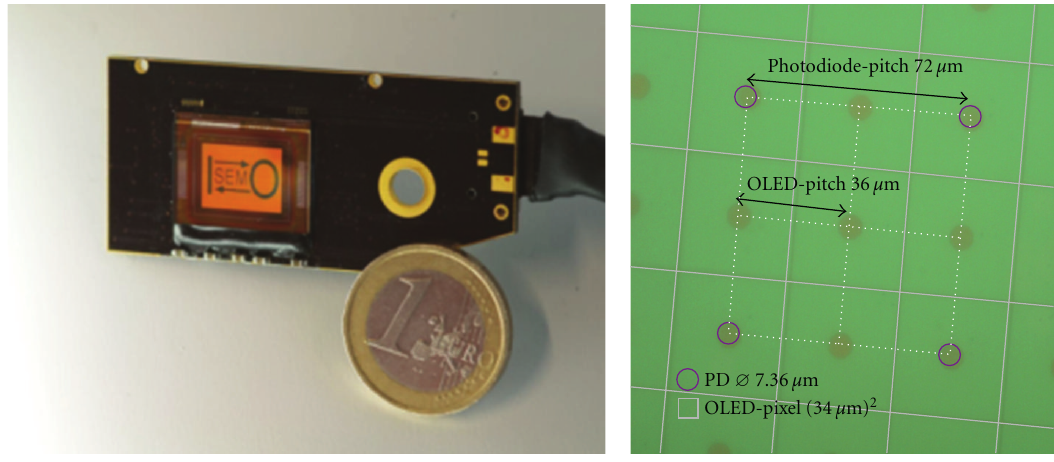
Figure 3: Bidirectional OLED-on-CMOS-microdisplay (at Fraunhofer IPMS).